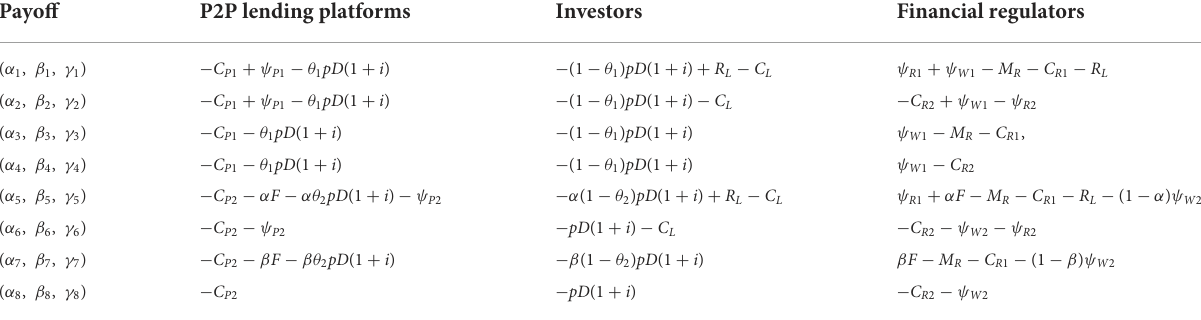
TABLE 2 The specific payoff of P2P lending platforms, investors, and financial regulators. Payoff P2P lending platforms